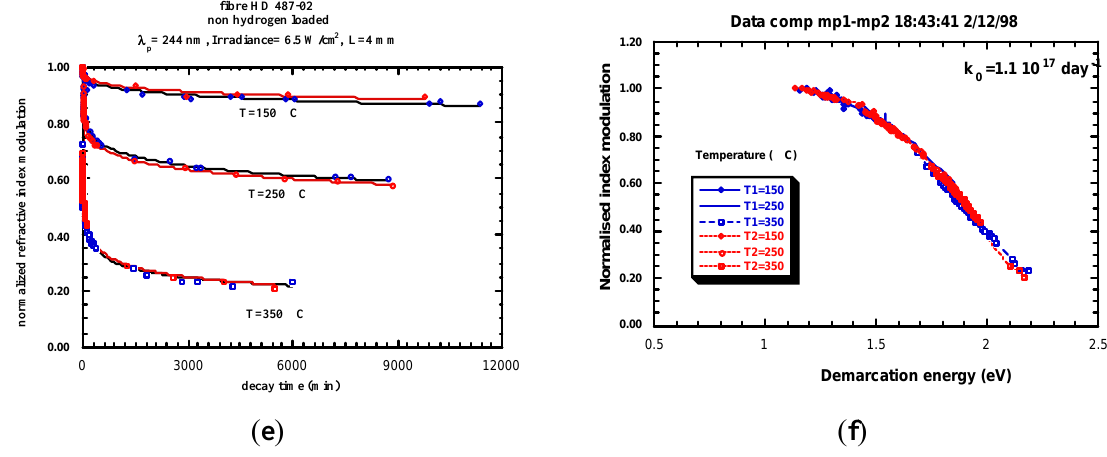
Figure 39. Set of isochrons and isotherm obtained by, reprinted with permission from [40]. Copyright 2000 University Lille 1. ( a , b ) compare isochrons obtained on the one hand and from one grating for each temperature, and on the other, with one grating by isochrones; ( c ) is the curve beam obtained after replotting, as mentioned in Section 3.1; ( d ) is the master curve deduced for the isochrones; ( e , f ) are isotherm experiments The same master curve is obtained after taking into account the temperature of the